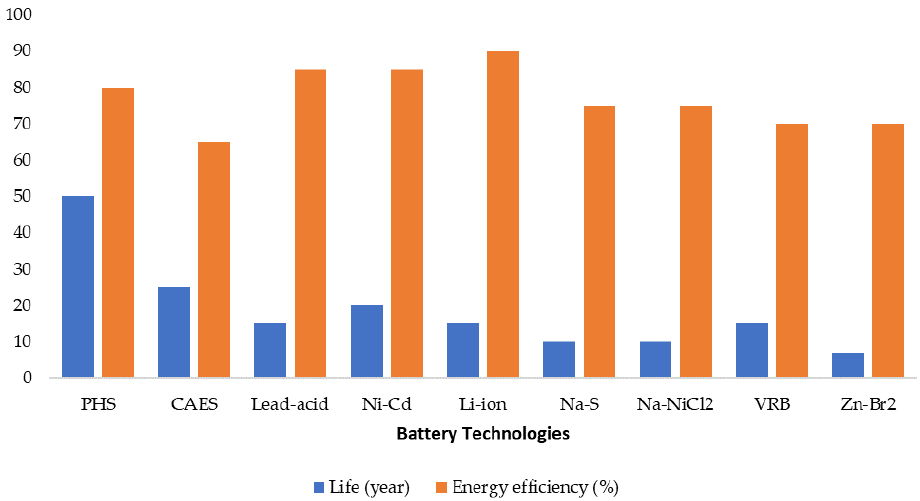
Figure 11. The income contributions made by various battery technologies globally.